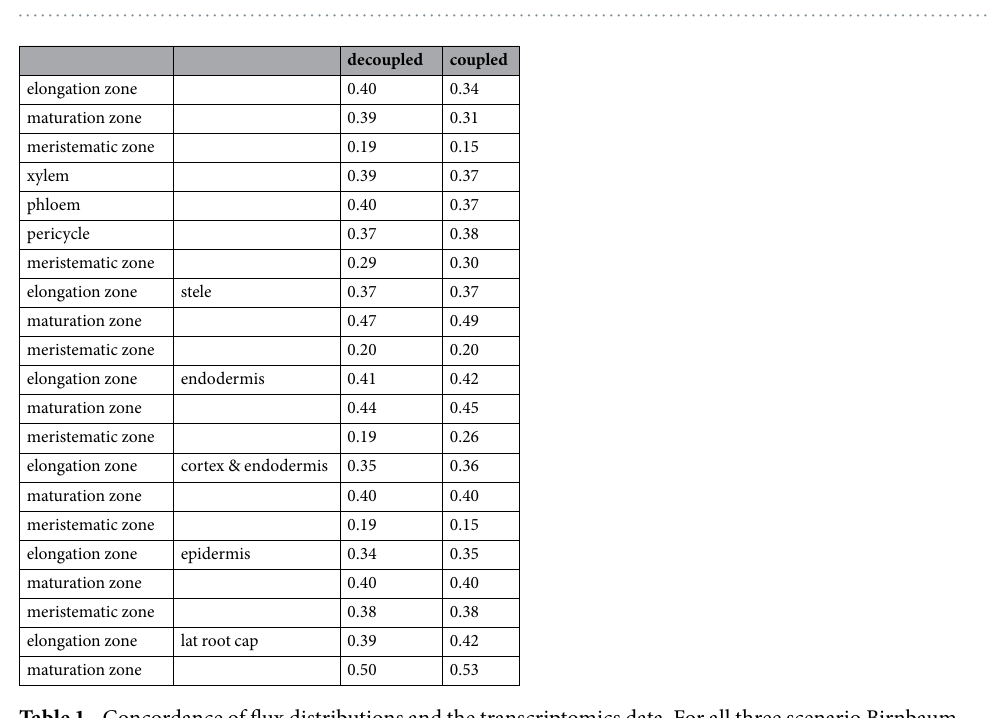
Figure 3. Number of extracted reactions. The number of reactions that are extracted from the initial model are given for three situations: ( a ) Transcriptomics data published by Birnbaum et al . are considered. The data is spatiotemporal resolved and covers the stele tissue and the cell-types endodermis (endo), cortex & endodermis (cortex/endo), epidermis (epi) and lateral root cap (lrc) for three developmental stages 1 (S1), the region between the root tip and 0.15 mm upwards (where the full diameter of the primary root is reached, stage 2 (S2), where cells originating from the root section between 0.15 mm to 0.30 − 0.45 mm away from the root tip, and stage 3 (S3), that is about 0.45 mm to 2 mm far away from the root tip. ( b ) Transcriptomics data published by Li et al . 25 are used spatial (cell-type) and ( c ) temporal (developmental stage) resolution.